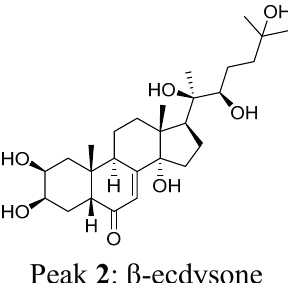
Peak 1 : gluconic acid Peak 2 : β